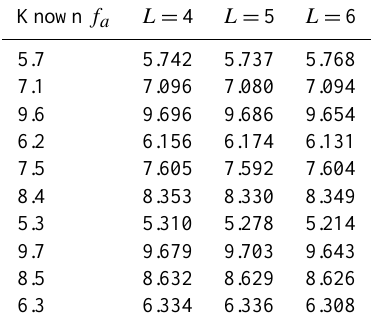
Table 1. Known and estimated forcing parameters for the Lorenz96 model at D = 10, and L = 4, 5, and 6. Known f a